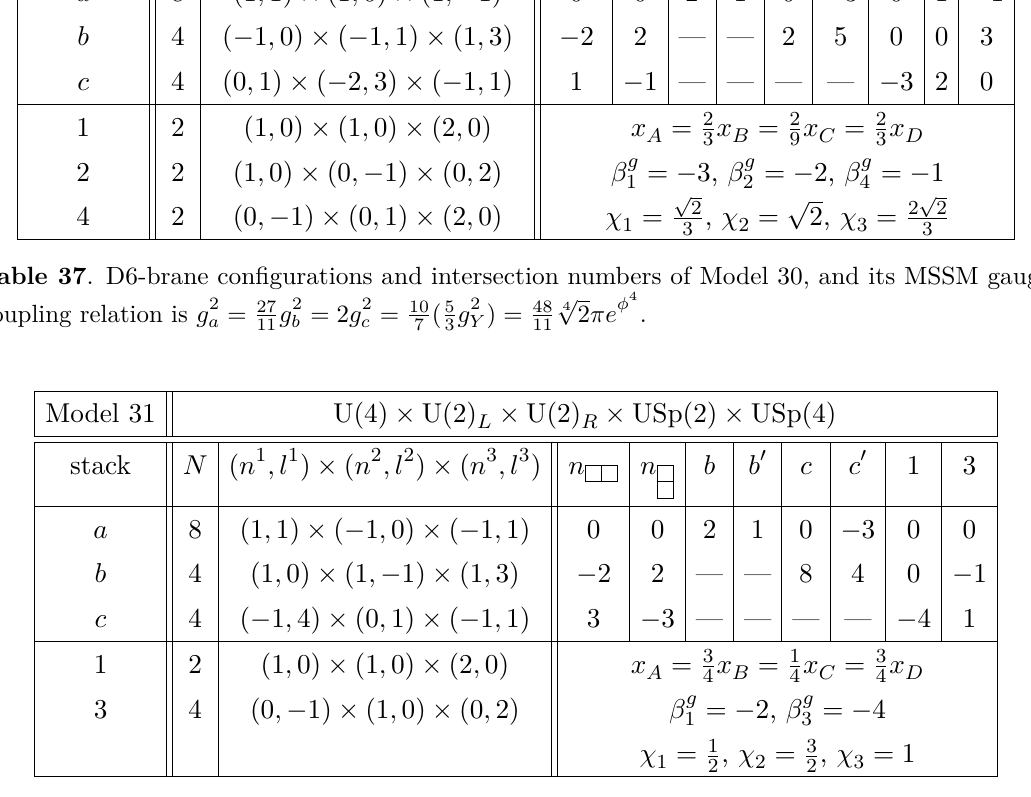
Table 38 . D6-brane configurations and intersection numbers of Model 31, and its MSSM gauge